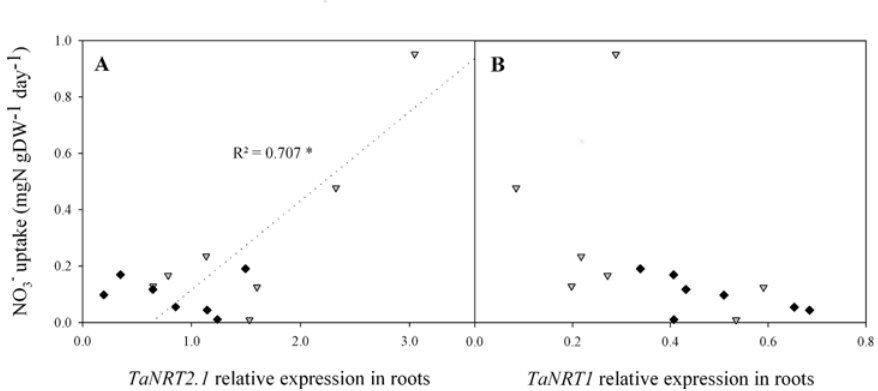
Fig 5. Relations between plant NO 3- uptake and relative expression levels of TaNRT2 . 1 (A) and TaNRT1 (B) in roots from flowering (GS65) to GS65+800DD for two contrasting NO 3- treatments (N4 and N10). Uptake data were obtained by substitution of previous nutrient solution by an identical one but labelled 10% 15 N nutrient solution 24 h before sampling. Values are means of eight biological repetitions for NO 3 - uptake and of three biological repetitions for gene expression for N4 (grey triangles) and N10 (black diamonds). Correlations are based on seven post-flowering sampling dates. Statistical analyses were by the Pearson correlation test. Gene expression quantification was performed by qRT-PCR. Relative expression values were calculated using the Δ CT method corrected for primer efficiency, using Ta54280 and Ta54948 as internal controls.